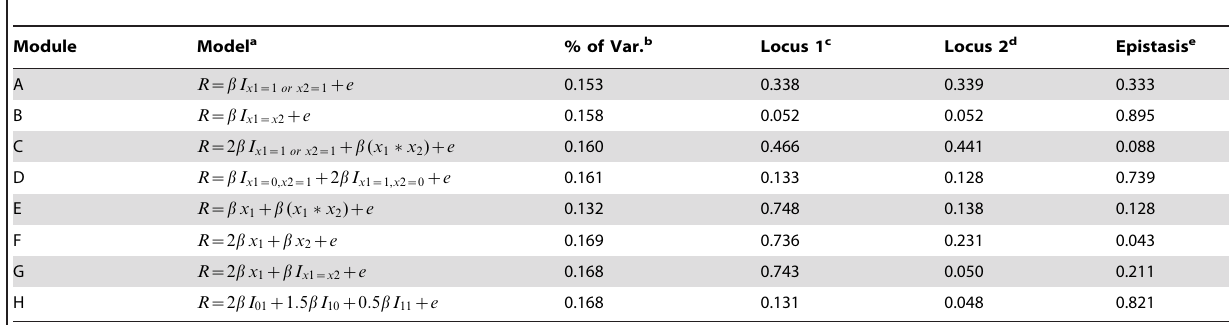
Table 1. Simulation design and genetic variance decomposition of different models.